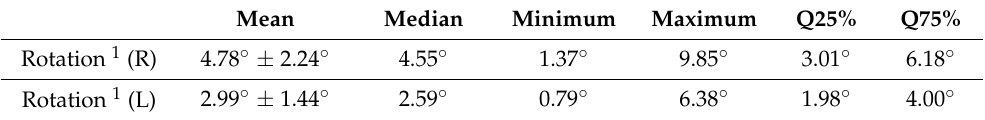
Table 2. Rotation [degrees] of the lumbar spine (L1–L5) measured with a dynamic spine-correction device (n = 54).